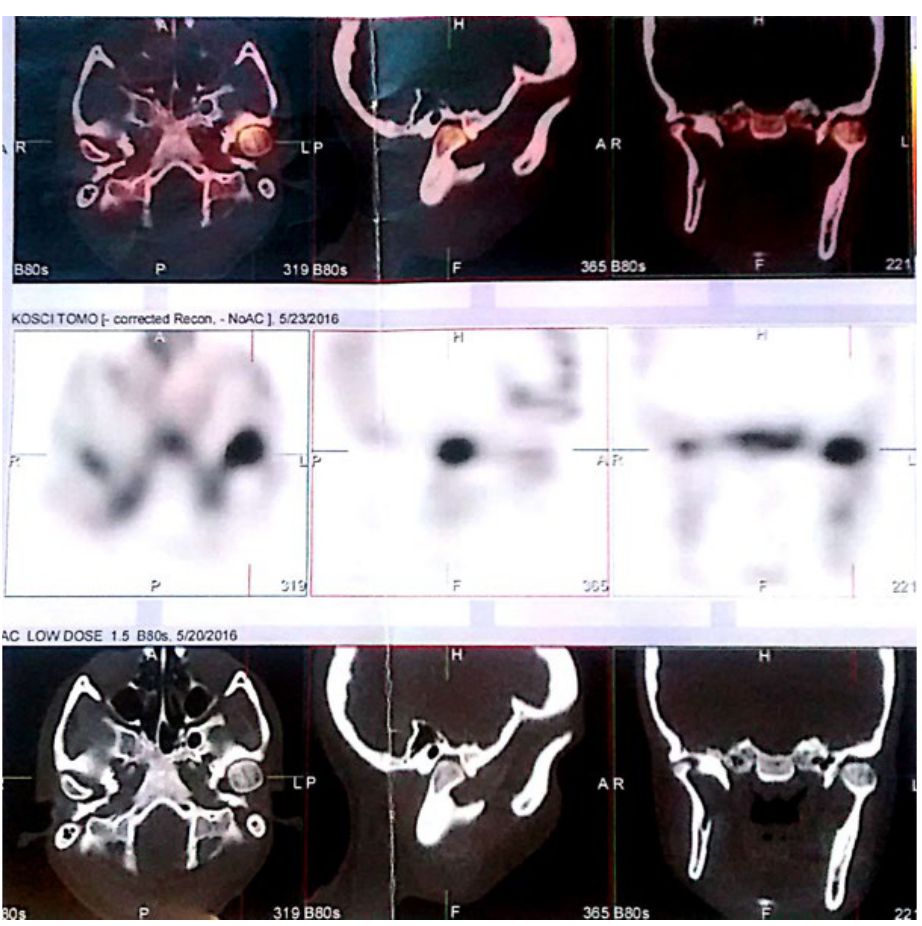
Figure 5. SPECT evaluation of left side UCH. Presence of enlarged left condylar head with osteosclerosis, typical decrease in glenoid fossa space, and enlarged left ramus of the mandible. Abbreviations: L —left, R—right, H—head/up; F—foot/down, A—anterior, P—posterior.